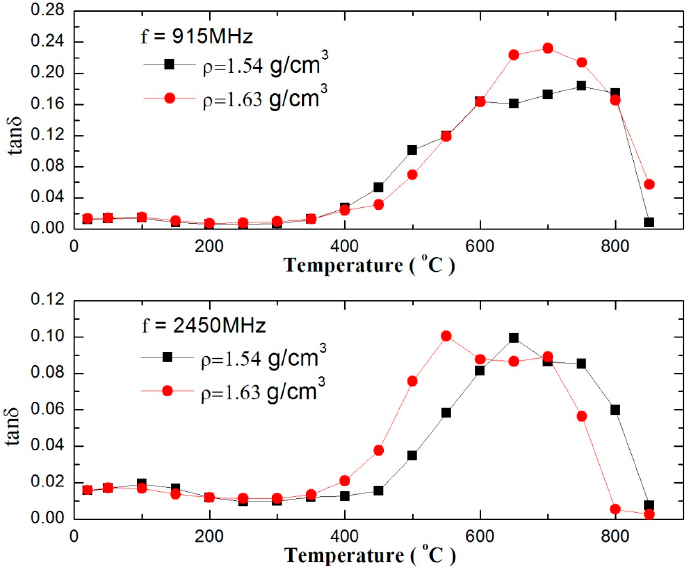
Figure 4. The variations of dielectric loss tangent of zinc sulfide concentrate with temperature.